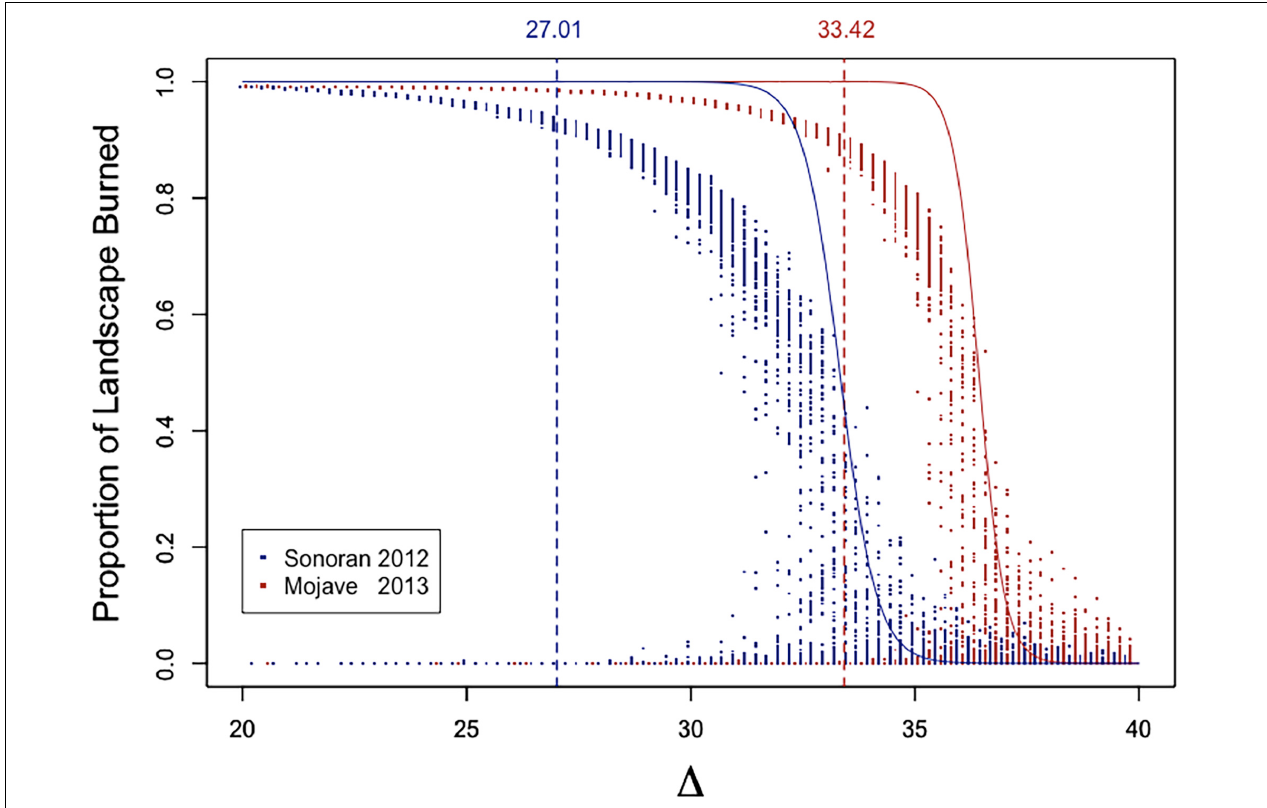
FIGURE 11 | Proportion of landscape burned by fire initiated within a single cell. Red points are replicates in the Mojave 2013 model and blue points in Sonoran 2012. Solid lines are the percolation probabilities shown in Figure 10 . Vertical dashed lines correspond to the biomass value that lies at p crit as predicted from the gamma distribution for OF sites ( Table 3